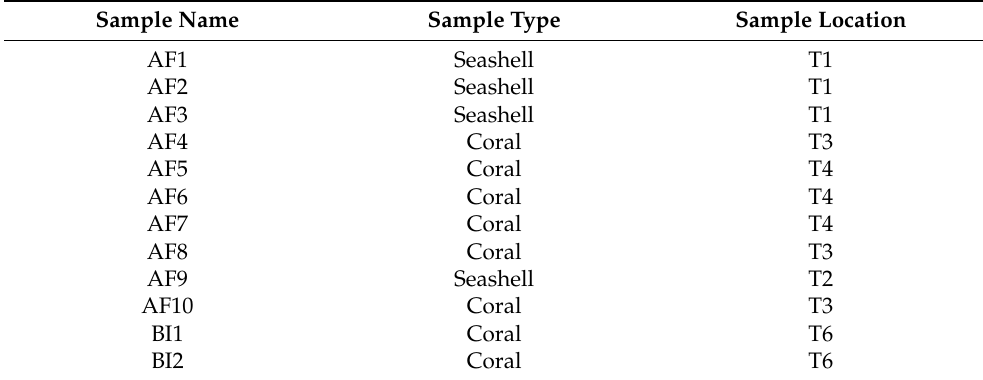
Table 1. Samples for radiocarbon